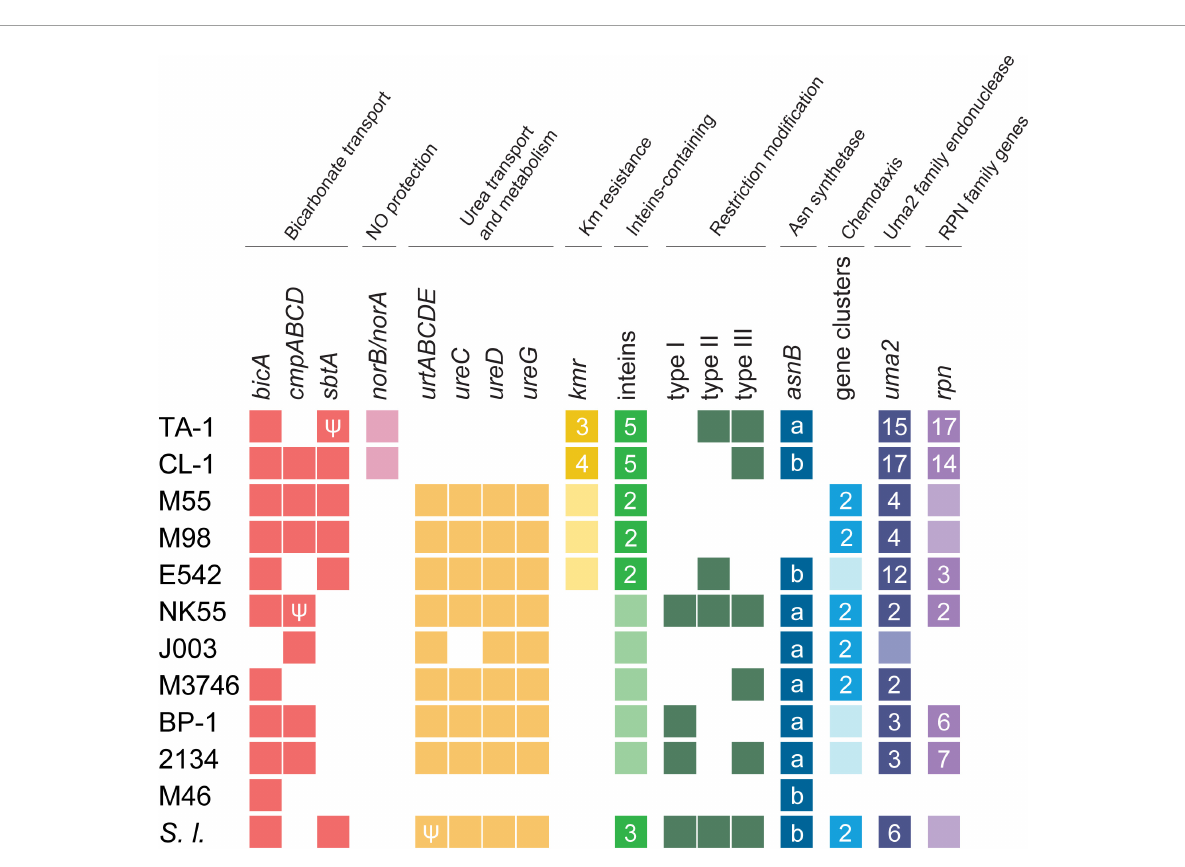
FIGURE3 Overview of notable genetic differentiation among representative Thermosynechococcus strains. Strain names are abbreviated according to Table 1 ; Synechococcus lividus ( S. l. ) is included as an outgroup. The gene copy numbers are presented in a heat map (absent, white background; single-copy, light-color background; multi-copy, dark-color background with the copy number labeled). Pseudogenes are indicated with the “ (cid:57) ” symbol. For the asparagine synthetase gene ( asnB ), the sequence types (i.e., “a” or “b”) are labeled. For uma2 and rpn , the counts include only intact homologs listed in the GenBank annotation ( Table 1